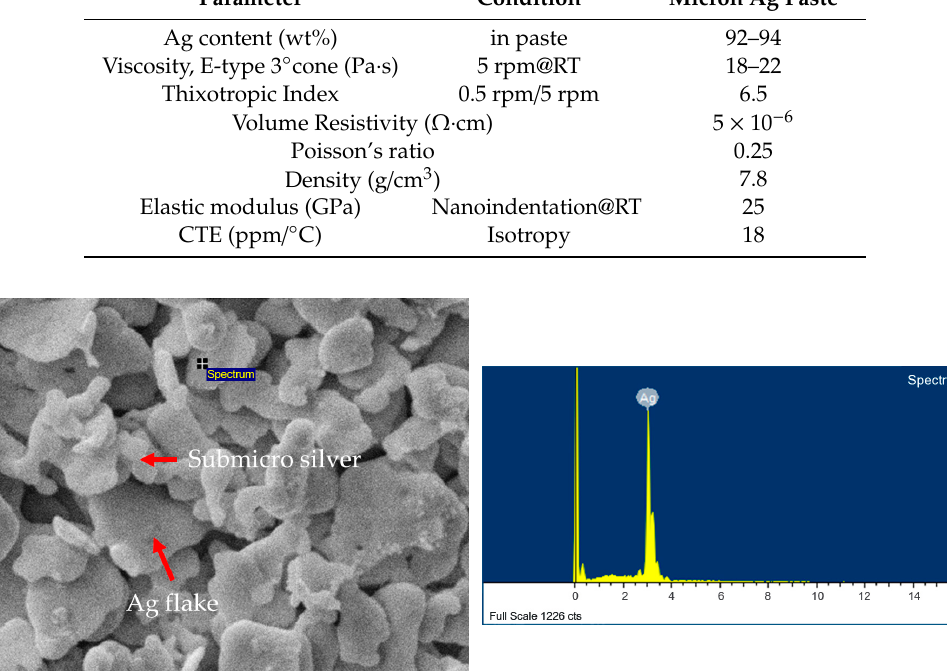
Figure 2. SEM image with spectrum spot and EDS analysis.